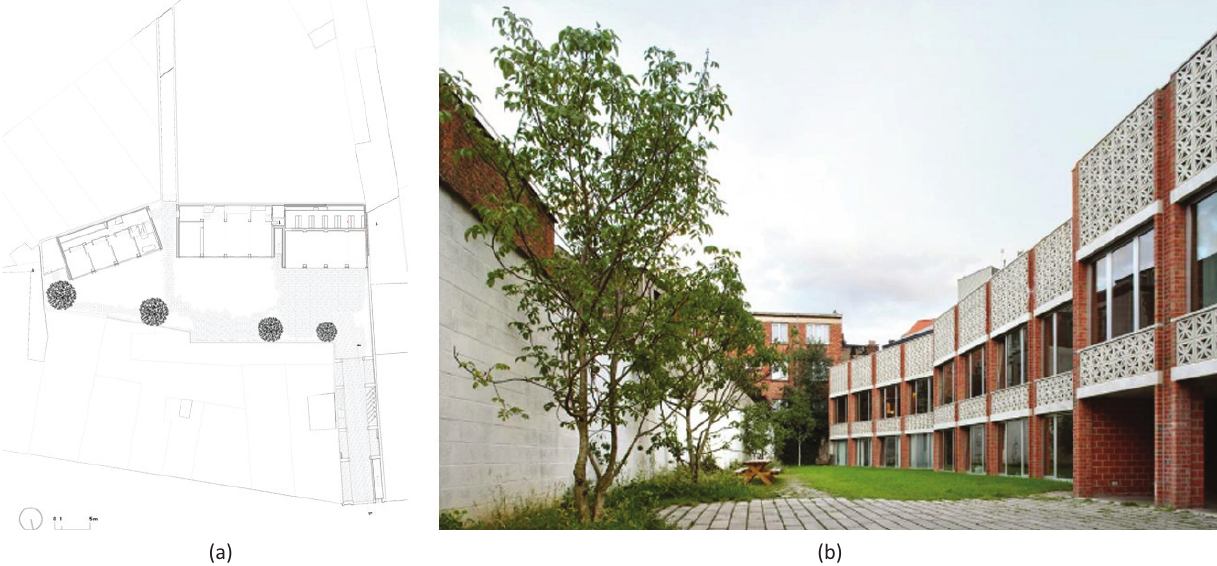
Figure 5. (a) Plan of the CH project of Collectief Noord. (b) View of the collective garden with dwellings. Sources: Courtesy of (a) Collectief Noord and (b) Filip